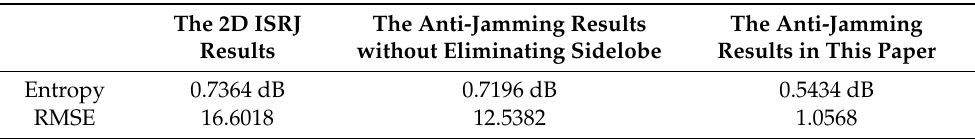
Table 8. Imaging entropies and RMSE values of three different algorithms. The 2D ISRJ